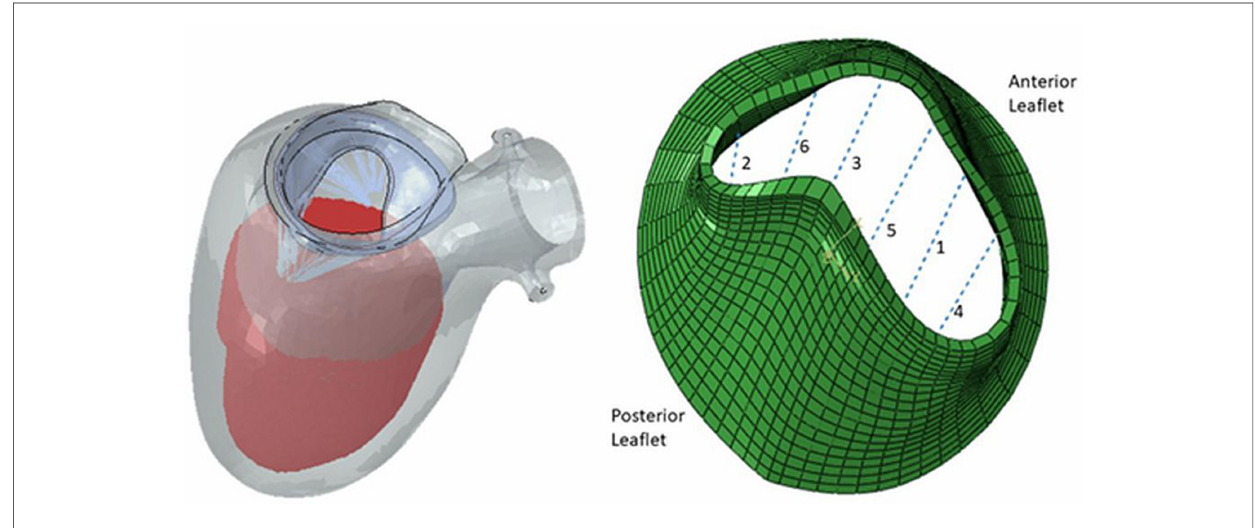
FIGURE 1 Finite element model of left ventricle and mitral valve apparatus (left) and mitral valve lea fl ets with six locations for possible MitraClip TM placement (right)